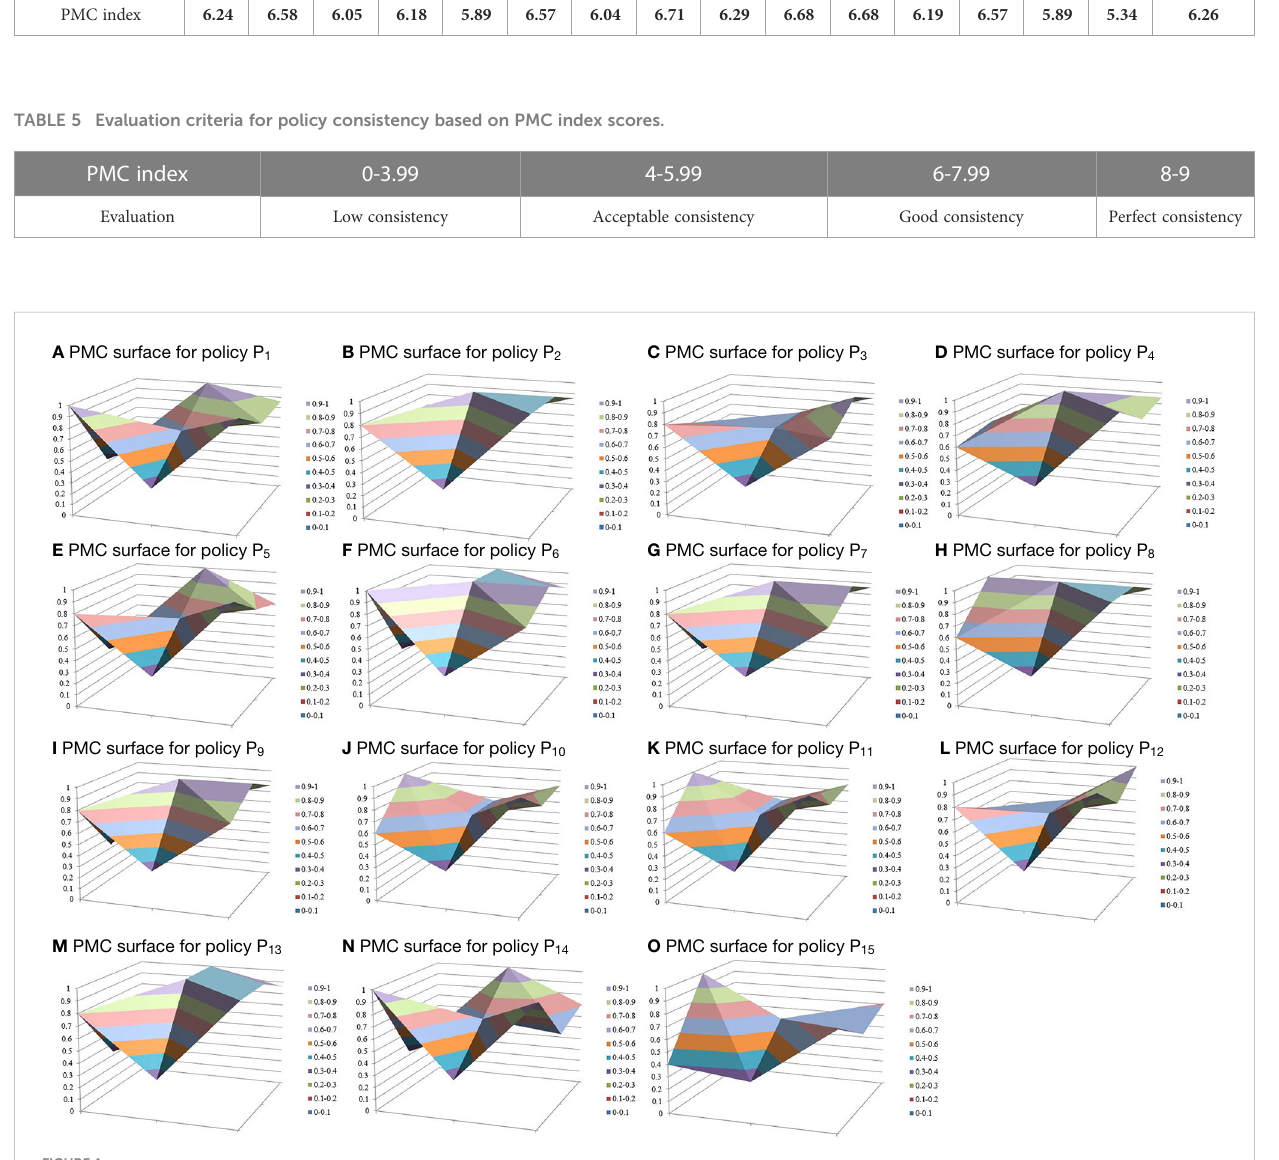
FIGURE 1 PMC surfaces for China ’ s shipping decarbonization policies. (A) PMC surface for policy P 1 . (B) PMC surface for policy P 2 . (C) PMC surface for policy P 3 . (D) PMC surface for policy P 4 . (E) PMC surface for policy P 5 . (F) PMC surface for policy P 6 . (G) PMC surface for policy P 7 . (H) PMC surface for policy P 8 . (I) PMC surface for policy P 9 . (J) PMC surface for policy P 10 . (K) PMC surface for policy P 11 . (L) PMC surface for policy P 12 . (M) PMC surface for policy P 13 . (N) PMC surface for policy P 14 . (O) PMC surface for policy P 15